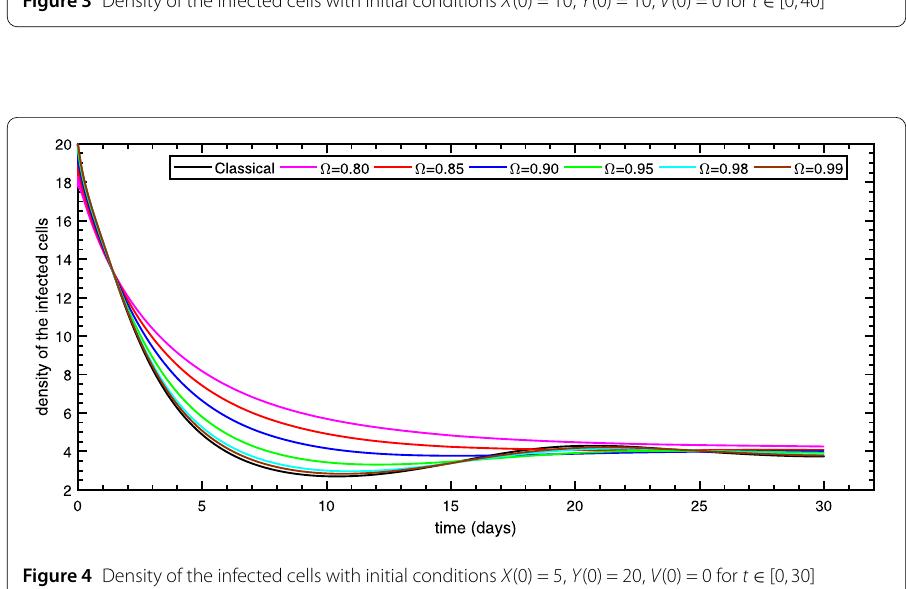
Figure 4 Density of the infected cells with initial conditions X (0) = 5, Y (0) = 20, V (0) = 0 for t ∈ [0,30]